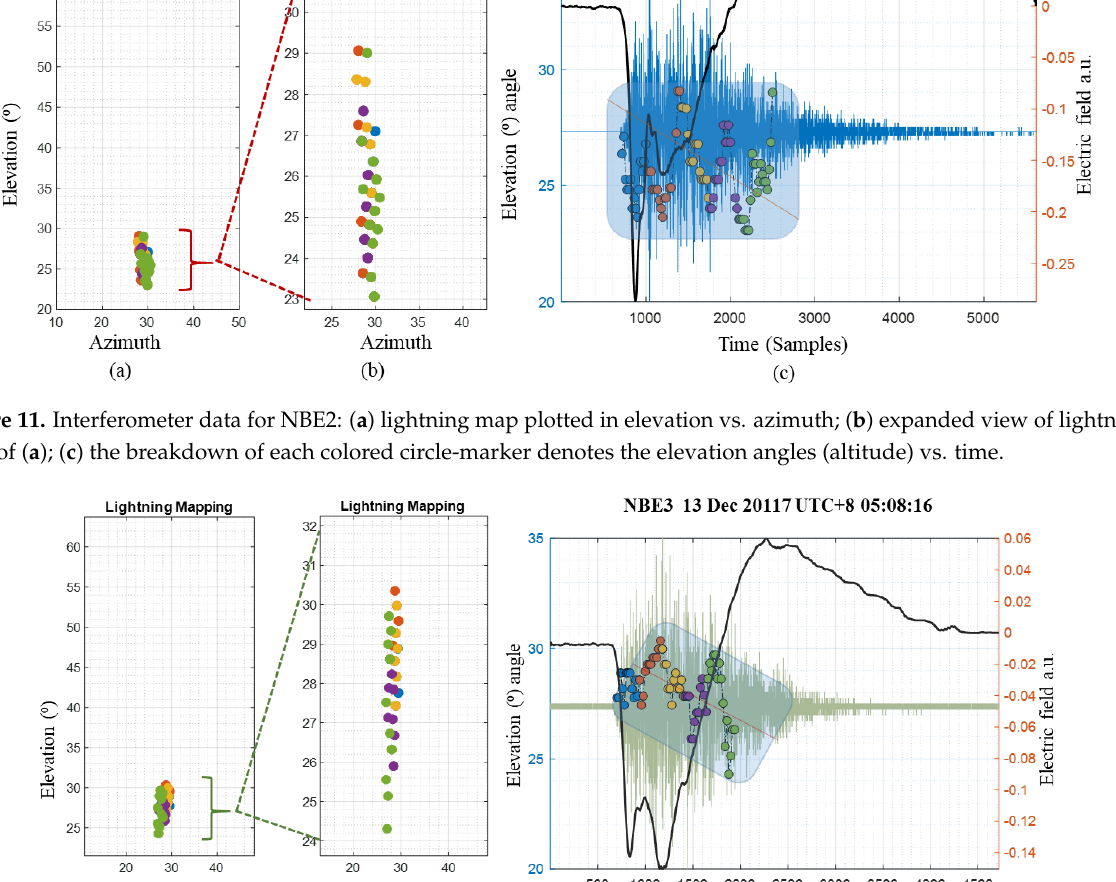
Figure 12. Interferometer data for NBE3: ( a ) lightning map plotted in elevation vs. azimuth; ( b ) expanded view of lightning map of ( a ); ( c ) the breakdown of each colored circle-marker denotes the elevation angles (altitude) vs. time.